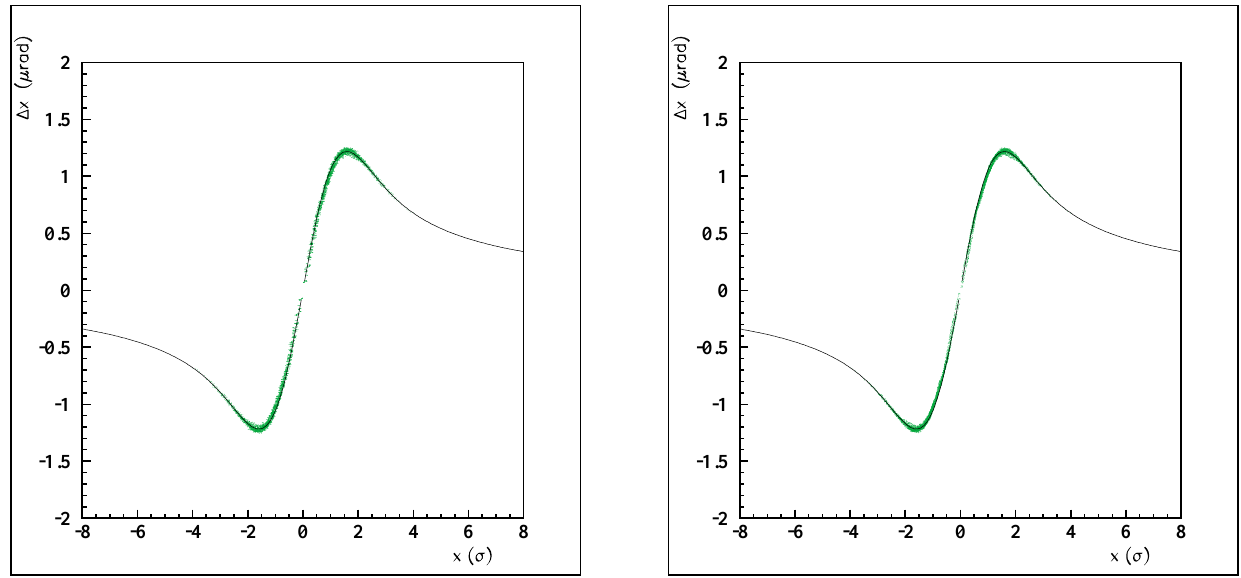
FIG. 2. (Color) Beam-beam kick as calculated with HFMM (points) and from analytical expression (solid line) for round beams with Gaussian distribution. Left: 0.10 s grid ( 201 3 201 ) and nearest-grid-point assignment. Right: CIC assignment. 054402-3